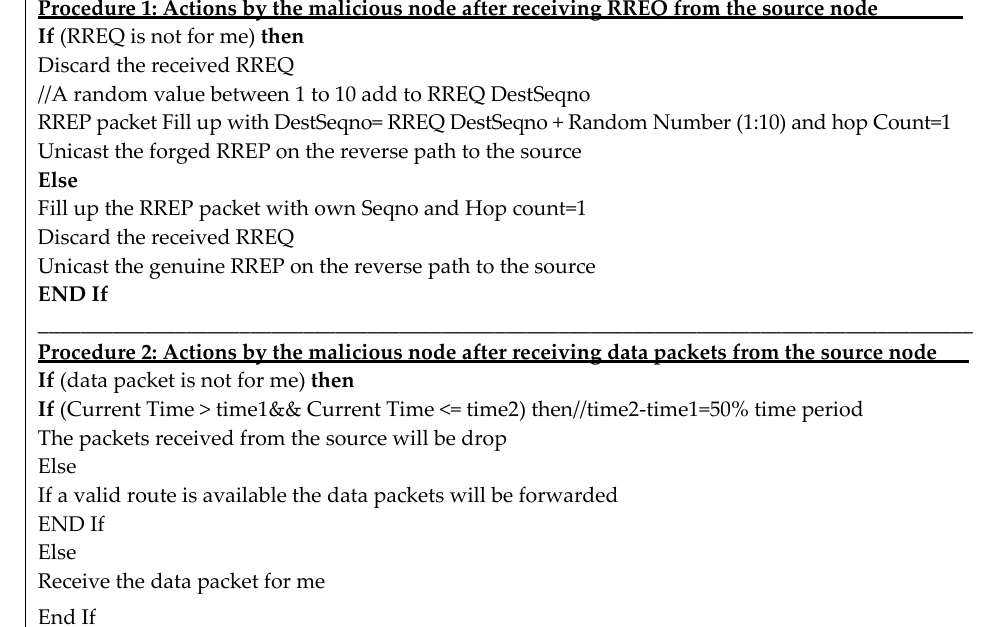
Figure 1. Adversary model. Route Request (RREQ); Route Reply (RREP).